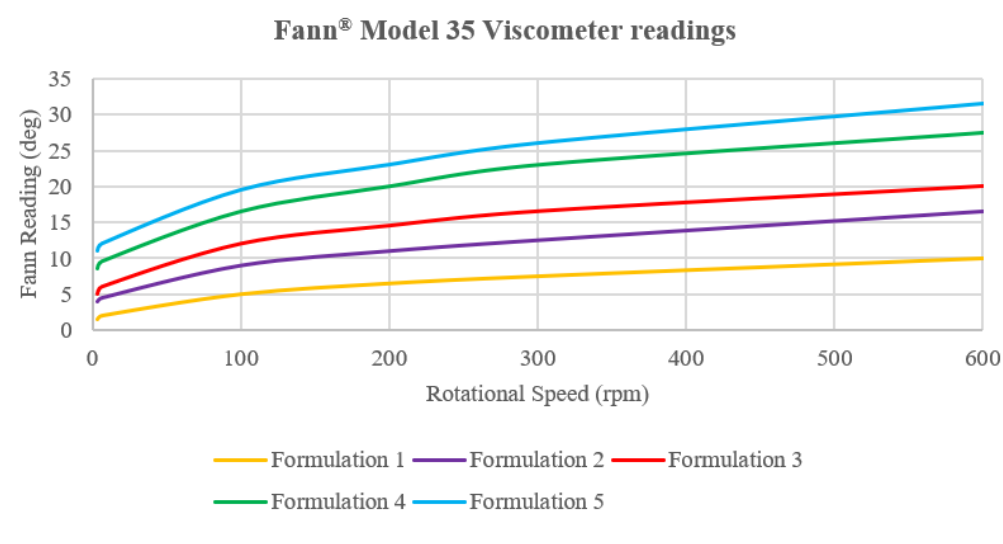
Figure 3: Comparison of Fann Model 35 Viscometer